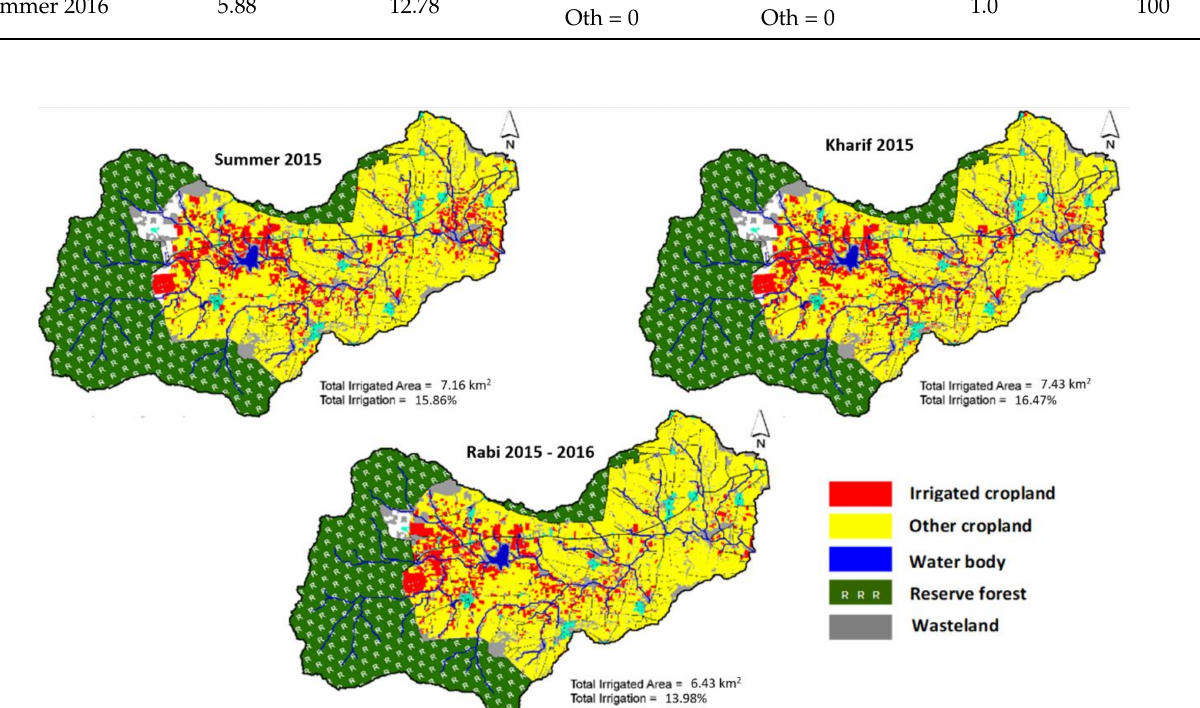
Figure 10. Classification of seasonal (summer; kharif; rabi) intensively irrigated cropland for 2015–2016. Fields with two-season and annual irrigation were located mainly in the watershed’s upstream area near drainage (Figure 11). The high irrigation intensity in the upstream area was due to the area’s shallower groundwater and groundwater recharge by the nearby reserve forest. Large fields with long-duration irrigation were located in the up- stream area due to its shallower groundwater [18].